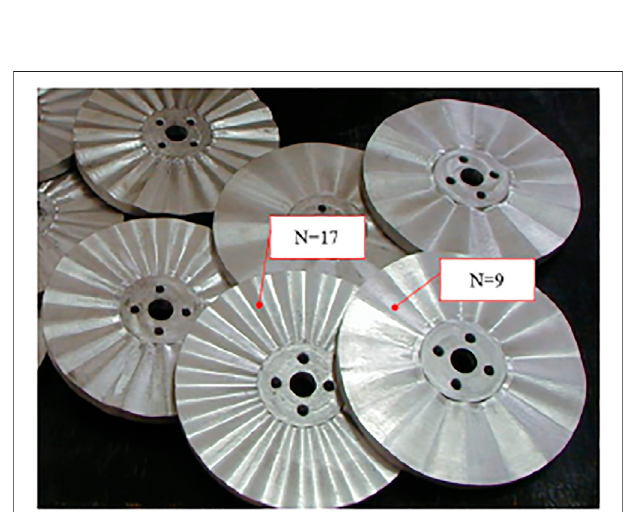
FIGURE 7 | The corrugated discs.